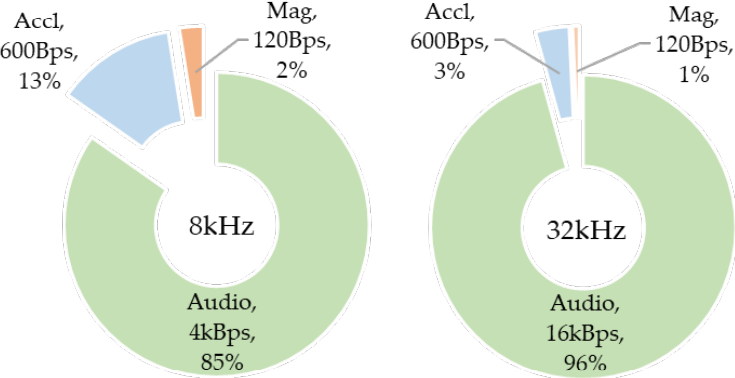
Figure 5. Data source contribution to mass storage (given in byte/s data rate).